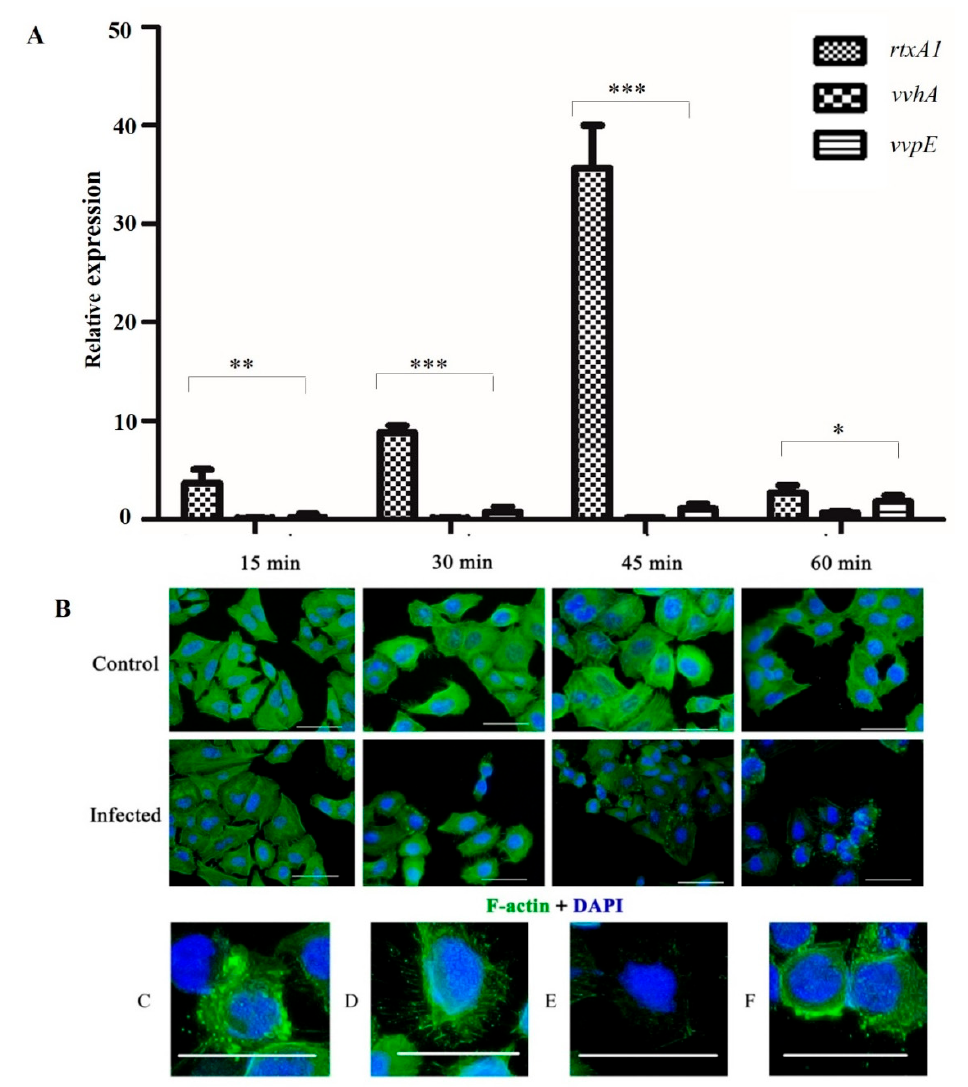
Figure 6. Effect of adhering V. vulnificus on F-actin network and nucleus of HeLa cells at different time points. HeLa cell monolayers were infected at an MOI of 5 and incubated for 1 h at 37 ◦ C. ( A ) The relative expression level of rtxA1 , vvhA and vvpE at the time of infection. Results are mean ± SD of triplicate experiments. Asterisks indicate significant differences in the expression of genes (* p < 0.05, ** p < 0.01 and *** p < 0.001). ( B ) Immunofluorescence images of HeLa under 20 × . Scale bar corresponds to 50 µ M. Images are overlays of actin (green) and nucleus (blue) signals. Descriptive features of HeLa cell at 1 h of postinfection; blebbing ( C ), discrete actin bundles ( D ), diffuse actin bundles ( E ), cell rounding ( F ).